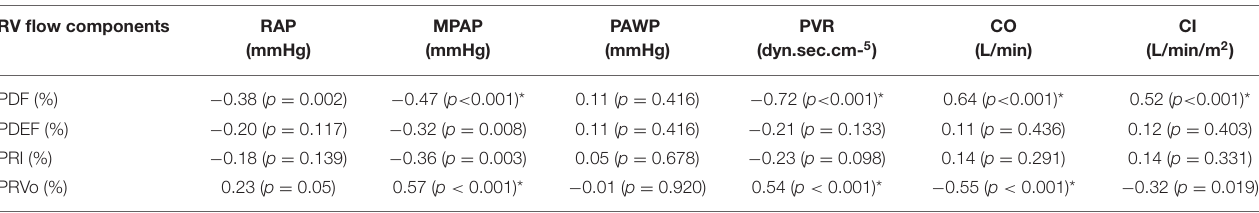
TABLE 3 | Correlation of right ventricular flow components with